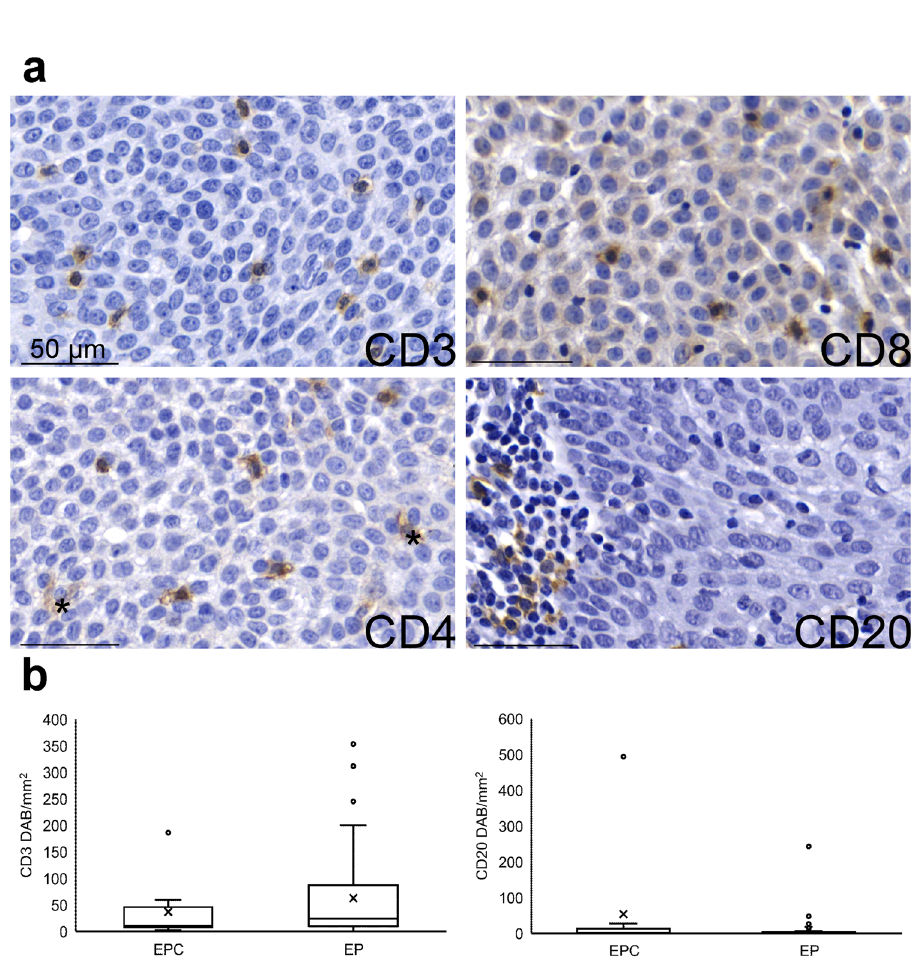
Figure 1. TIL density in EPCs and EPs. ( a ) Representative pictures of immunohistochemistry. * = macrophages. Scale bar = 50um. ( b ) Comparison of the density of CD3+ cells and CD20+ cells between EPCs and EPs. EPC n = 10, EP n = 48. Mean and median of the density of CD3+ cells was 36.9 ± 17.6 and 10.1 respectively in EPCs and 62.7 ± 12.0, 23.8 in EPs. p = 0.313. Mean and median of the density of CD20+ cells was 54.0 ± 48.9, 1.4 in EPCs and 9.6 ± 5.2, 1.3 in